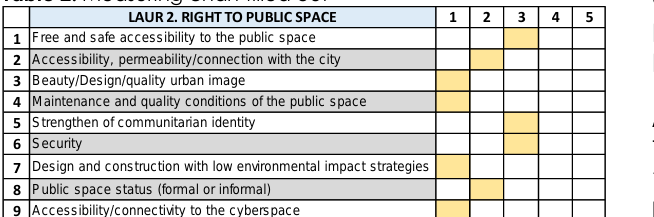
Table 2. Measuring chart filled